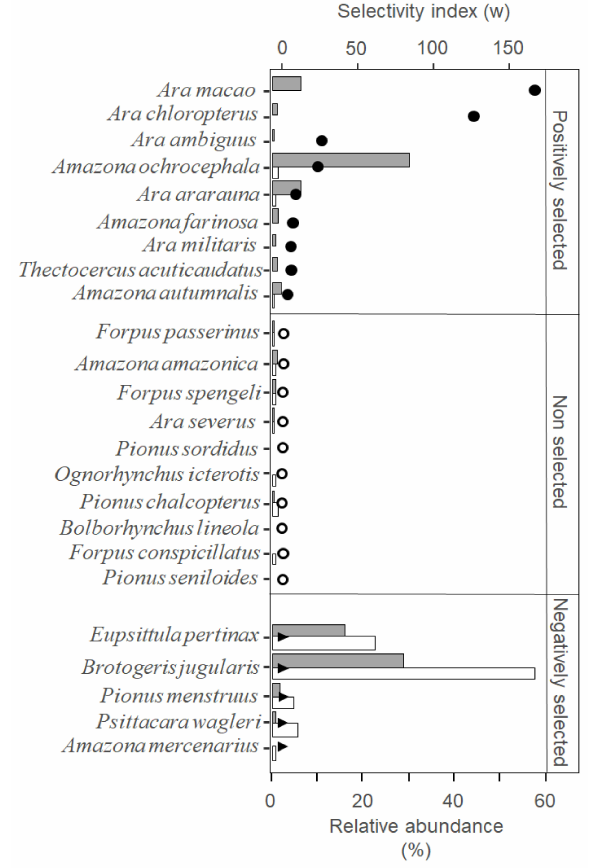
Figure 5. Relative abundance of parrots in Colombia as pets (dark gray bars) and in the wild (white bars), and Savage selectivity index (W; black dots: significant positive selection; black triangles: significant negative selection; white dots: not